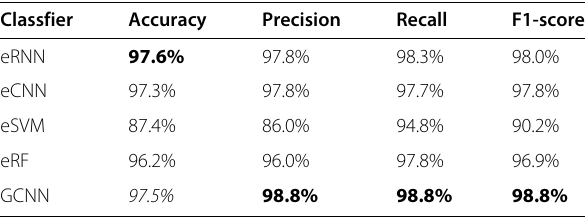
Table 7 The performance of models trained with augmented